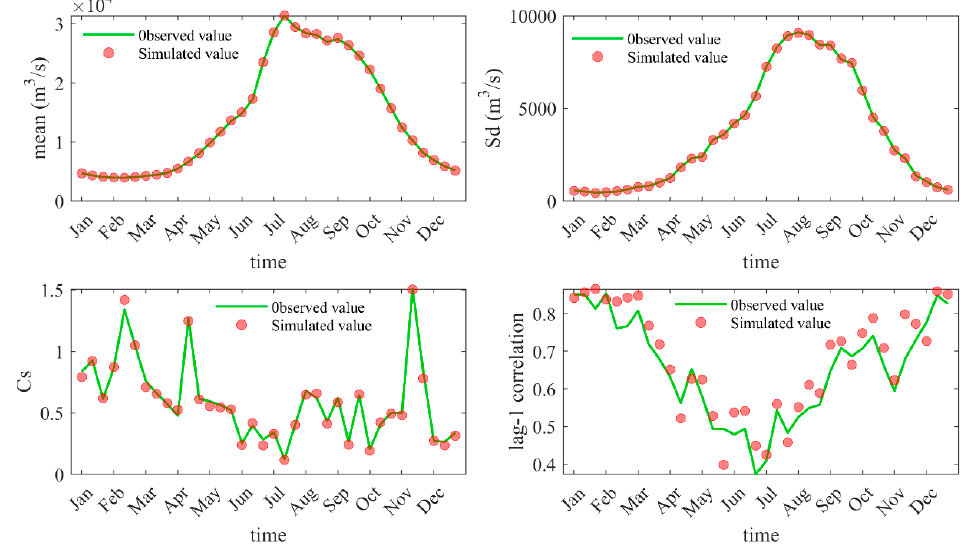
Figure 6. Basic statistics of observed and generated reservoir inflow series.